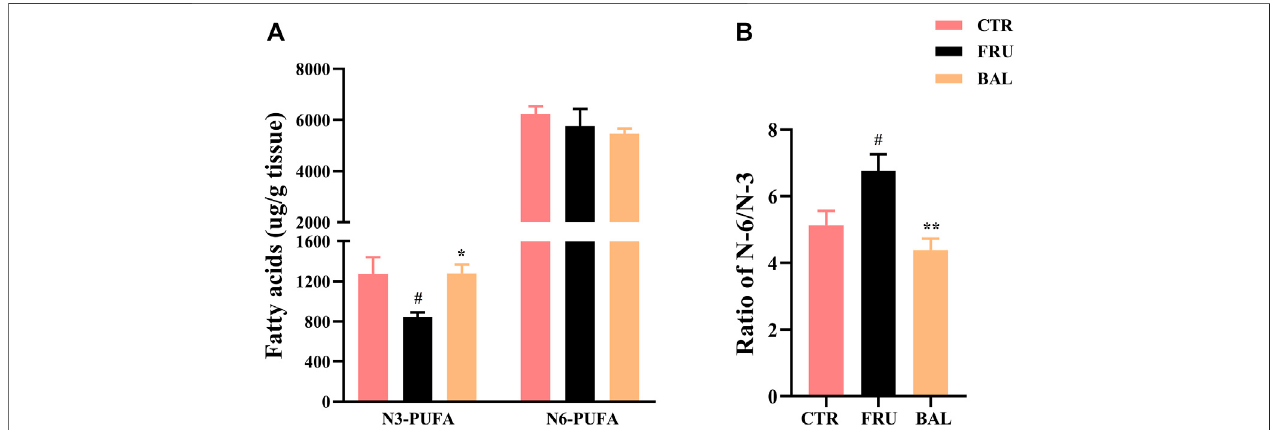
FIGURE5 | N-3 and N-6 PUFA in liver offructose-fedrats. (A) Contentsof thehepatic N-3 and N-6 PUFA. (B) Ratio ofN-6 and N-3 PUFA.Datawere represented as Mean ± SEM ( n = 6/group), ## p < 0.01 , # p < 0.05 , compared with CTR; **p < 0.01 , *p < 0.05 , compared to FRU.